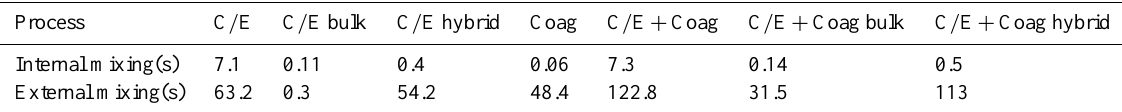
Table 3. Computational